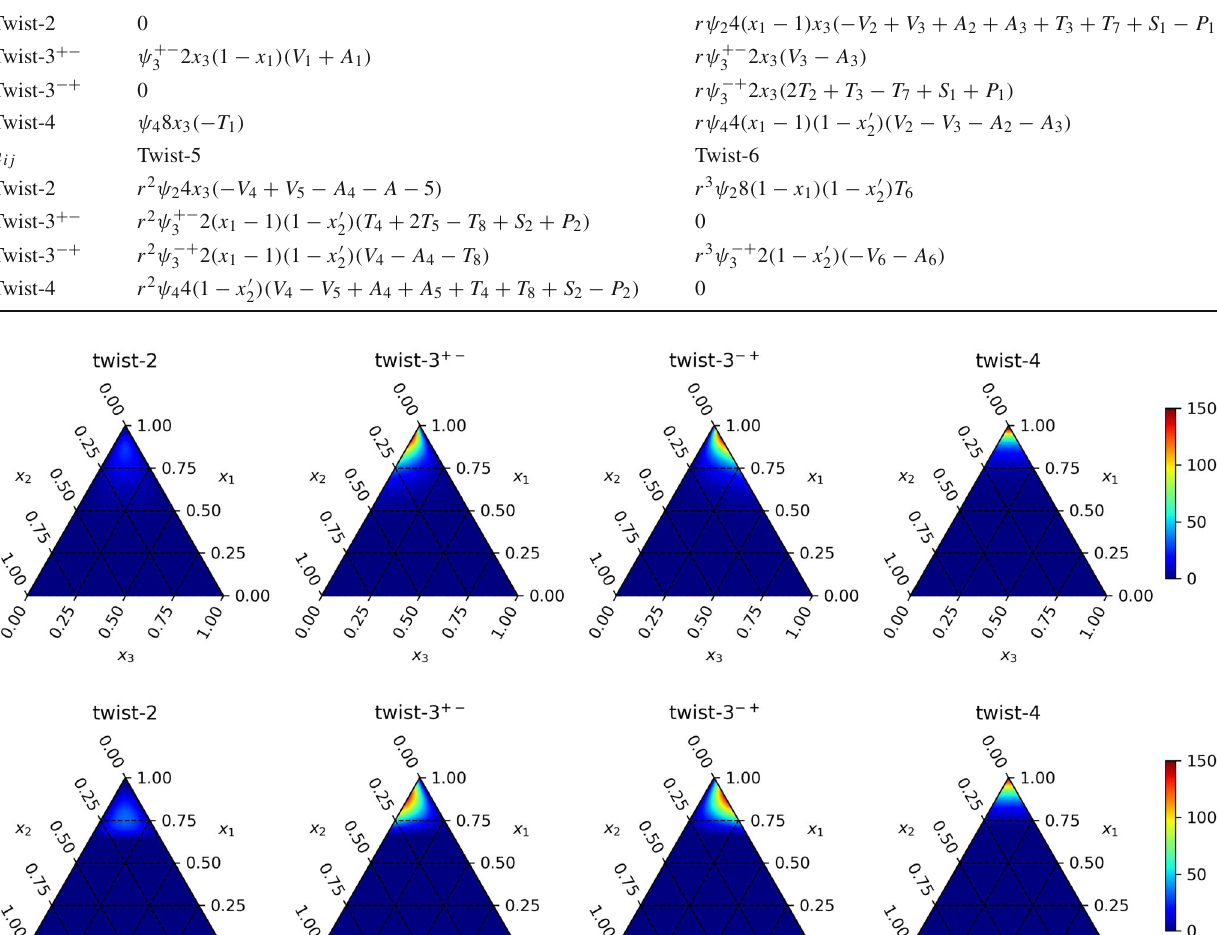
, ψ −+ and ψ 4 on the momentum fractions x i for the exponential model (top) and the 3 3